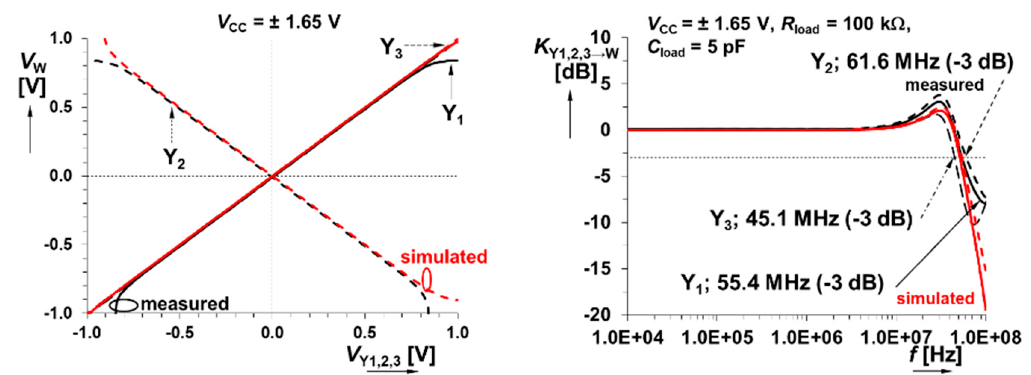
Figure 6. Selected results of the measured and simulated responses of the VDDB: (left) DC transfer responses Y 1–3 → W ; (right) magnitude AC transfer responses Y 1–3 → W .